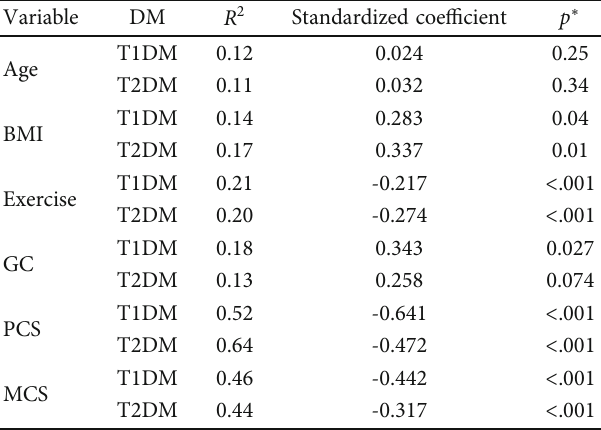
Table 4: Linear regression between diabetes distress and age, BMI, exercise glycemic control, Physical Component Summary, and Mental Component Summary in T1DM and T2DM